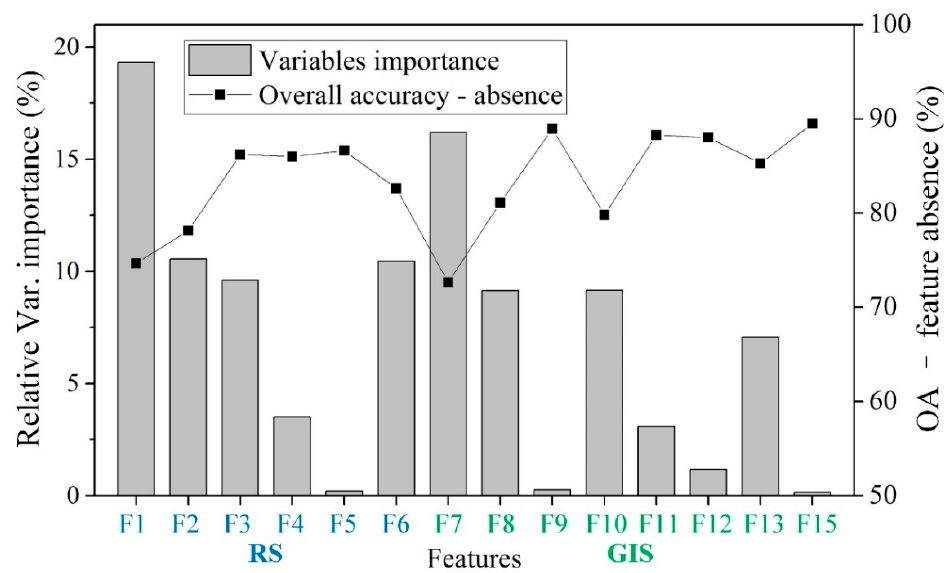
Figure 6. The relative variable importance (sum up to 100%) of the six RS features and the eight GIS features in urban extraction based on the OOB error. The overall accuracy (OA) of the absence of a related feature with 13 features as the training input. The feature codes can be found in Table 2.